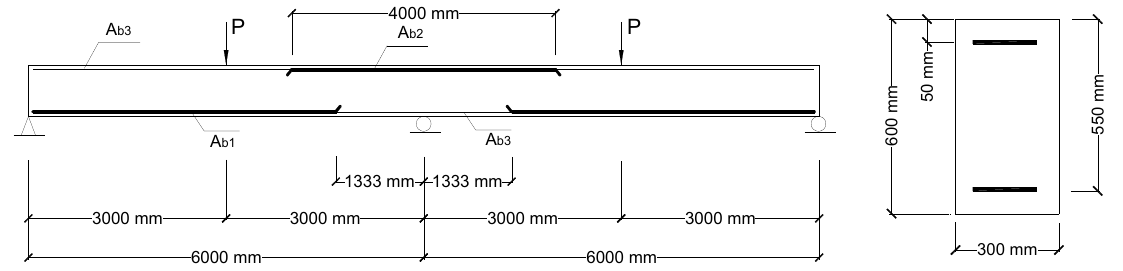
Figure 3. RC continuous beams for numerical evaluation (schematic diagram).